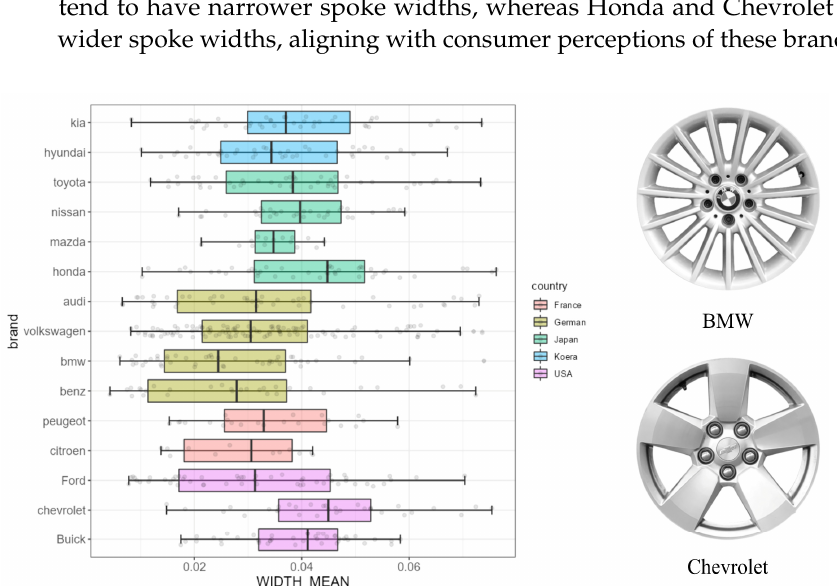
Figure 17. Spoke width based on different brands. The x-axis is the average spoke width on each wheel and the y-axis is the brand. The larger the value, the wider the spokes overall. In the graph, BMW has a narrower average spoke width, while Chevrolet has a wider average spoke width.